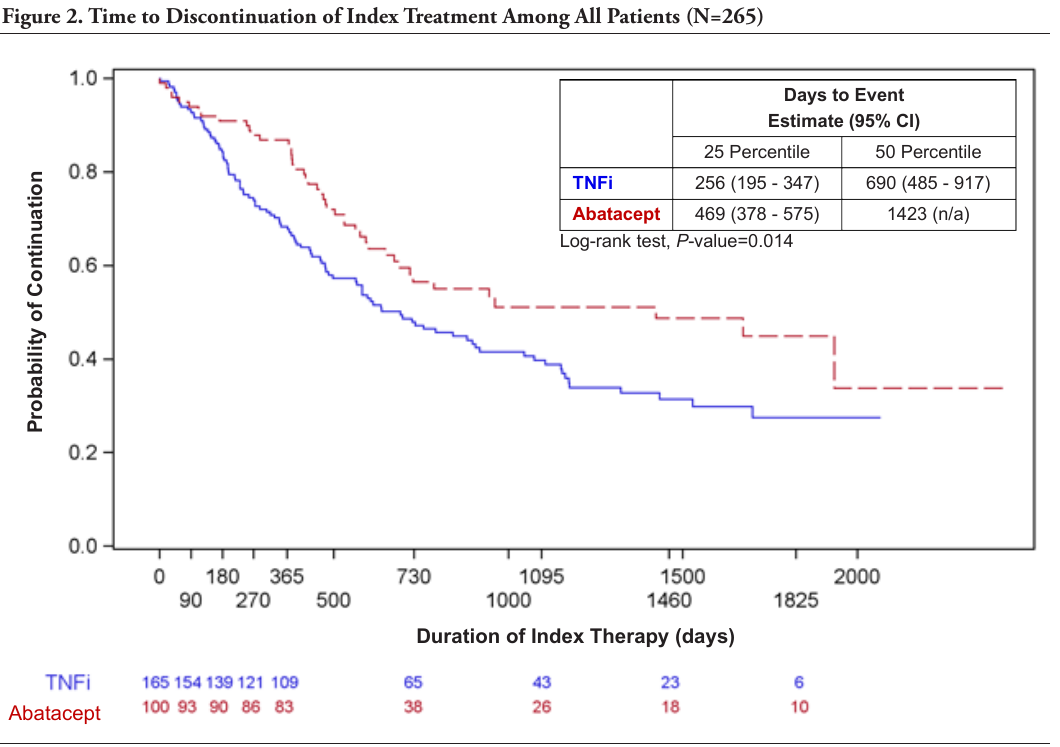
Figure 2. Time to Discontinuation of Index Treatment Among All Patients